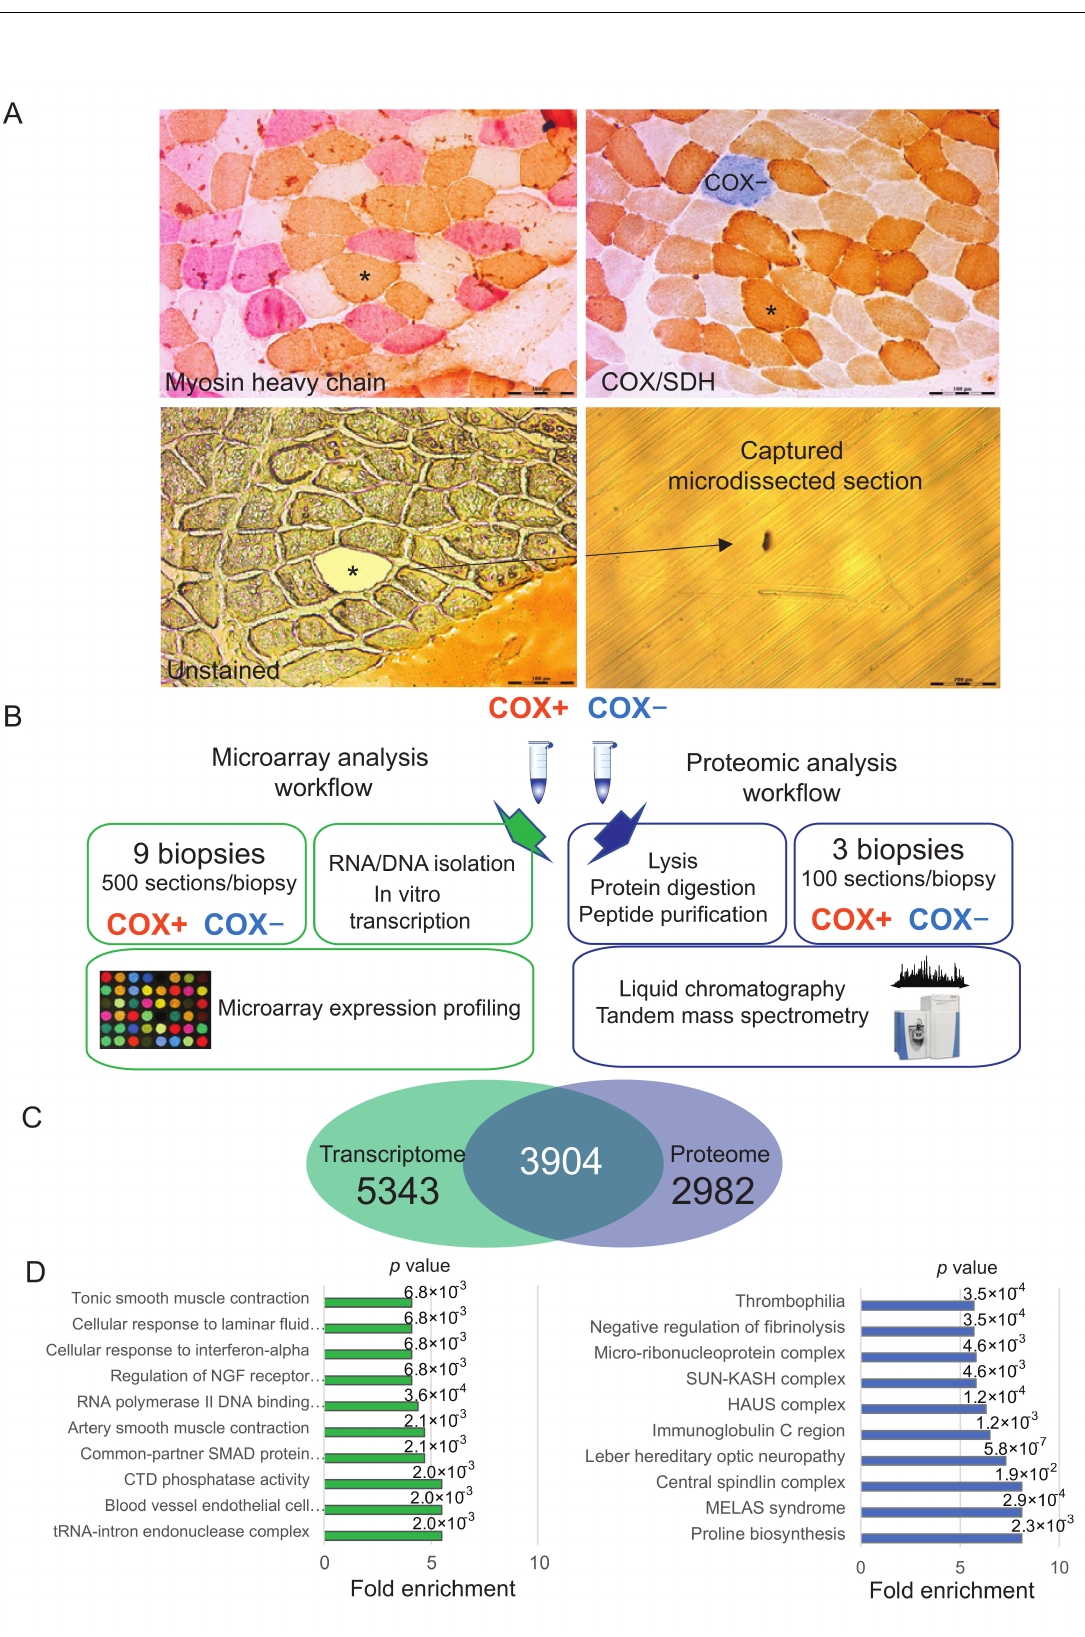
Figure 1. Laser capture microdissection-based workflows and features of the datasets. ( A ) Serial sections of skeletal muscle from a patient suffering from chronic progressive external ophthalmoplegia CPEO. Top left, myosin heavy chain staining for fiber type (brown, type 1-slow fibers; pink, fast-2A fibers.; white, fast-2X fibers). Top right, cytochrome c oxidase (COX)/succinate dehydrogenase (SDH) staining. Bottom left, unstained serial section used for laser microdissection as indicated. The fiber labeled with an asterisk in the serial sections was microdissected, as schmatically depicted Bar, 200 µ